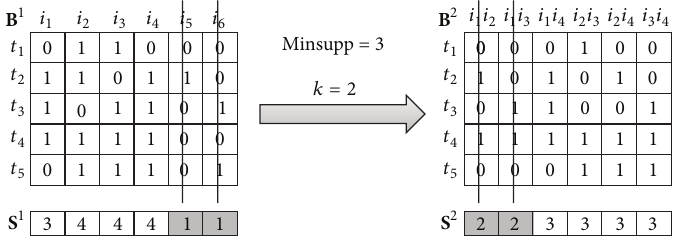
Figure 4: Mining process example using the bit-table